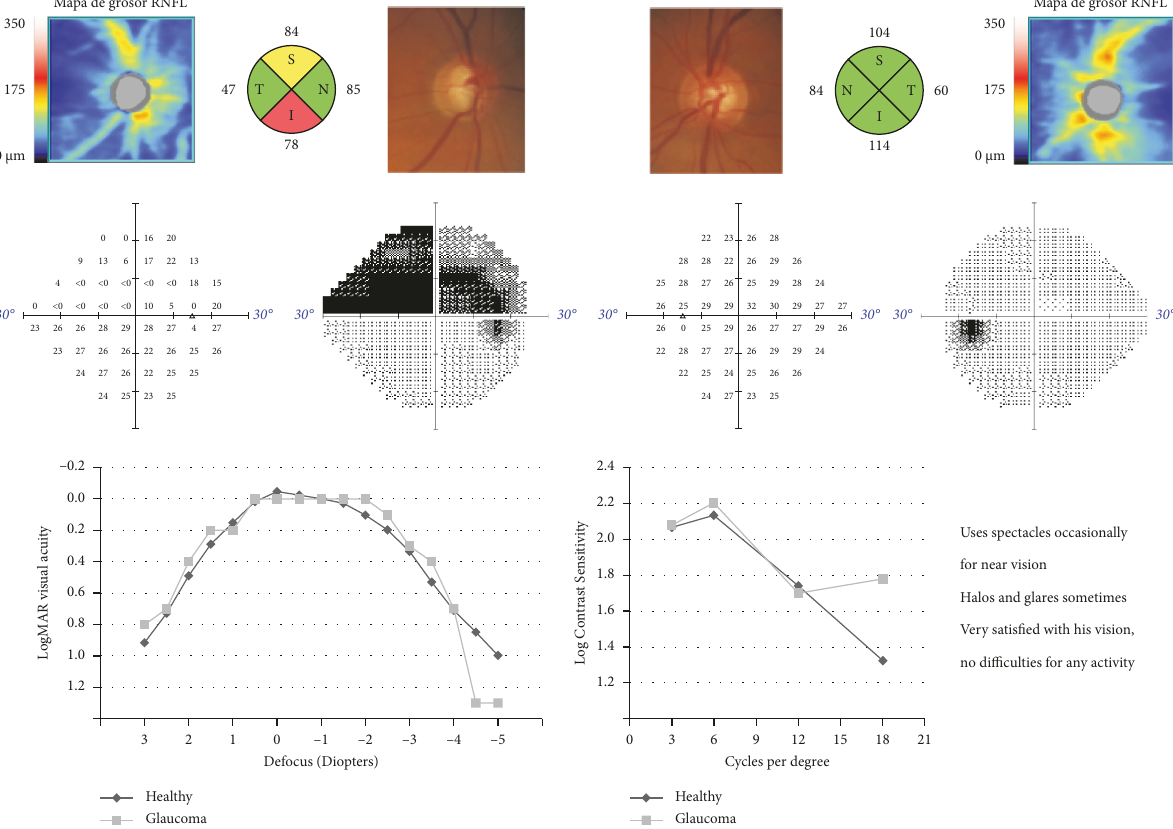
Figure 2: Visual fields, optic nerve optical coherence tomography, and visual results after bilateral Vivity intraocular lens implantation combined with I-Stent injection in a 74-year-old man with bilateral glaucoma with severe visual field damage in the right eye. The combined results of the healthy control group are shown for